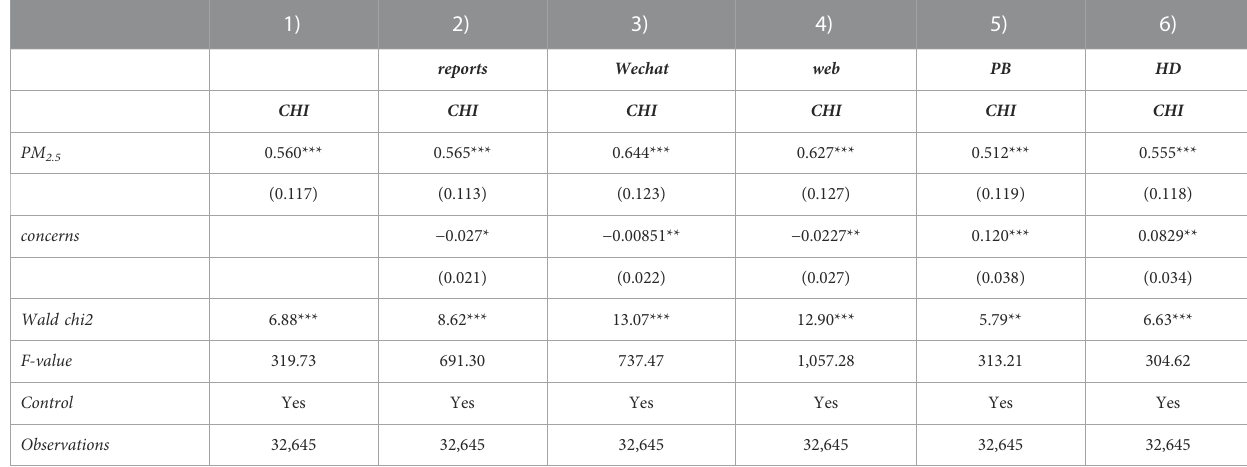
TABLE 4 Results of the mechanism test with